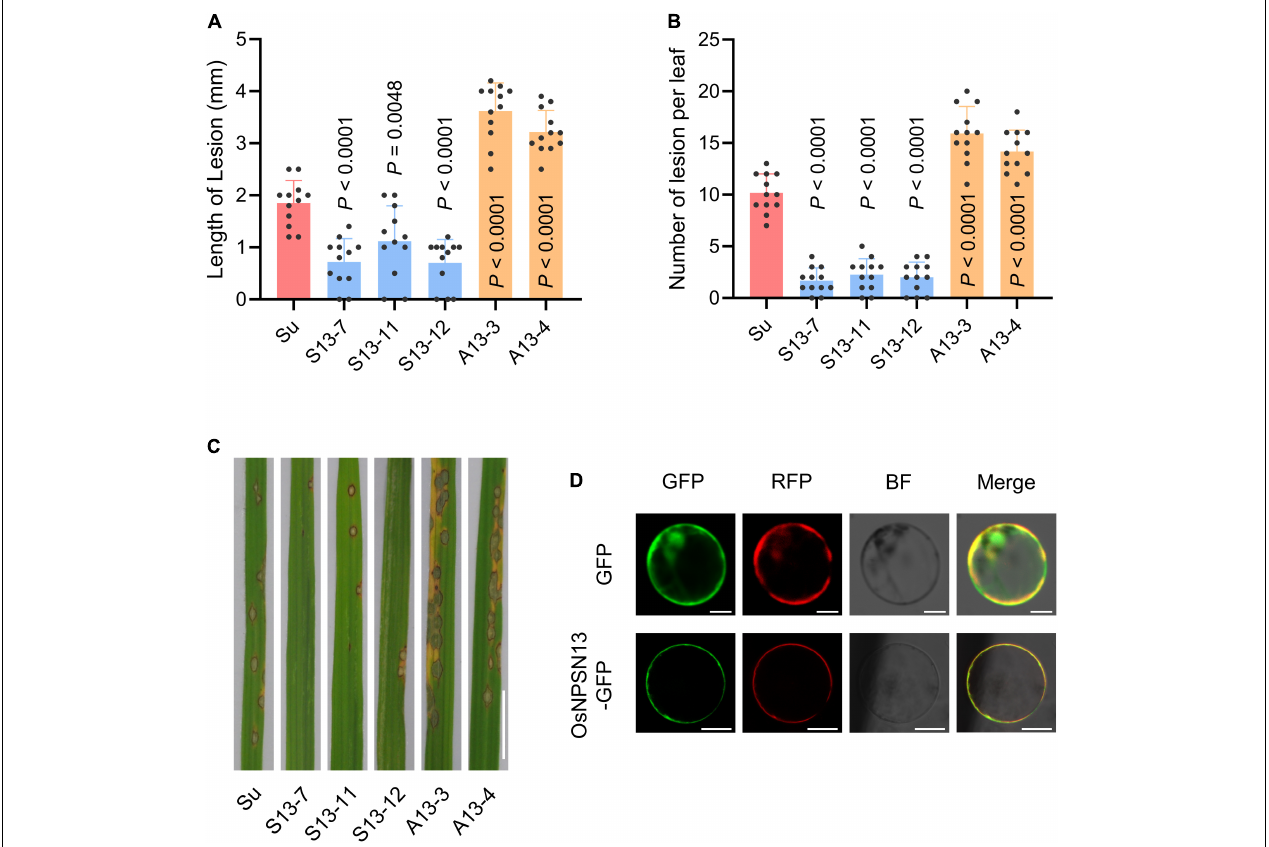
FIGURE 7 | Resistance phenotype of representative transgenic plants expressing OsNPSN13 and the subcellular localization of OsNPSN13. (A) Lesion length in wild-type Su and transgenic plants expressing OsNPSN13 at 7 dpi with M. oryzae . (B) Lesion number per leaf in wild-type Su and transgenic plants expressing OsNPSN13 inoculated with M. oryzae at 7 dpi. S13, transgenic overexpression lines; A13, transgenic knockdown lines. The bar charts show the average, standard deviation ( n = 12) and p -value. (C) Rice blast resistance phenotypes of transgenic plants and wild-type Su inoculated with M. oryzae strain Hoku1. The leaves with lesions are shown. Bar = 1 cm. (D) The subcellular localization of OsNPSN13 transiently expressed in rice protoplasts. OsAMT3.2-RFP was used as PM marker. Bar = 5 µ